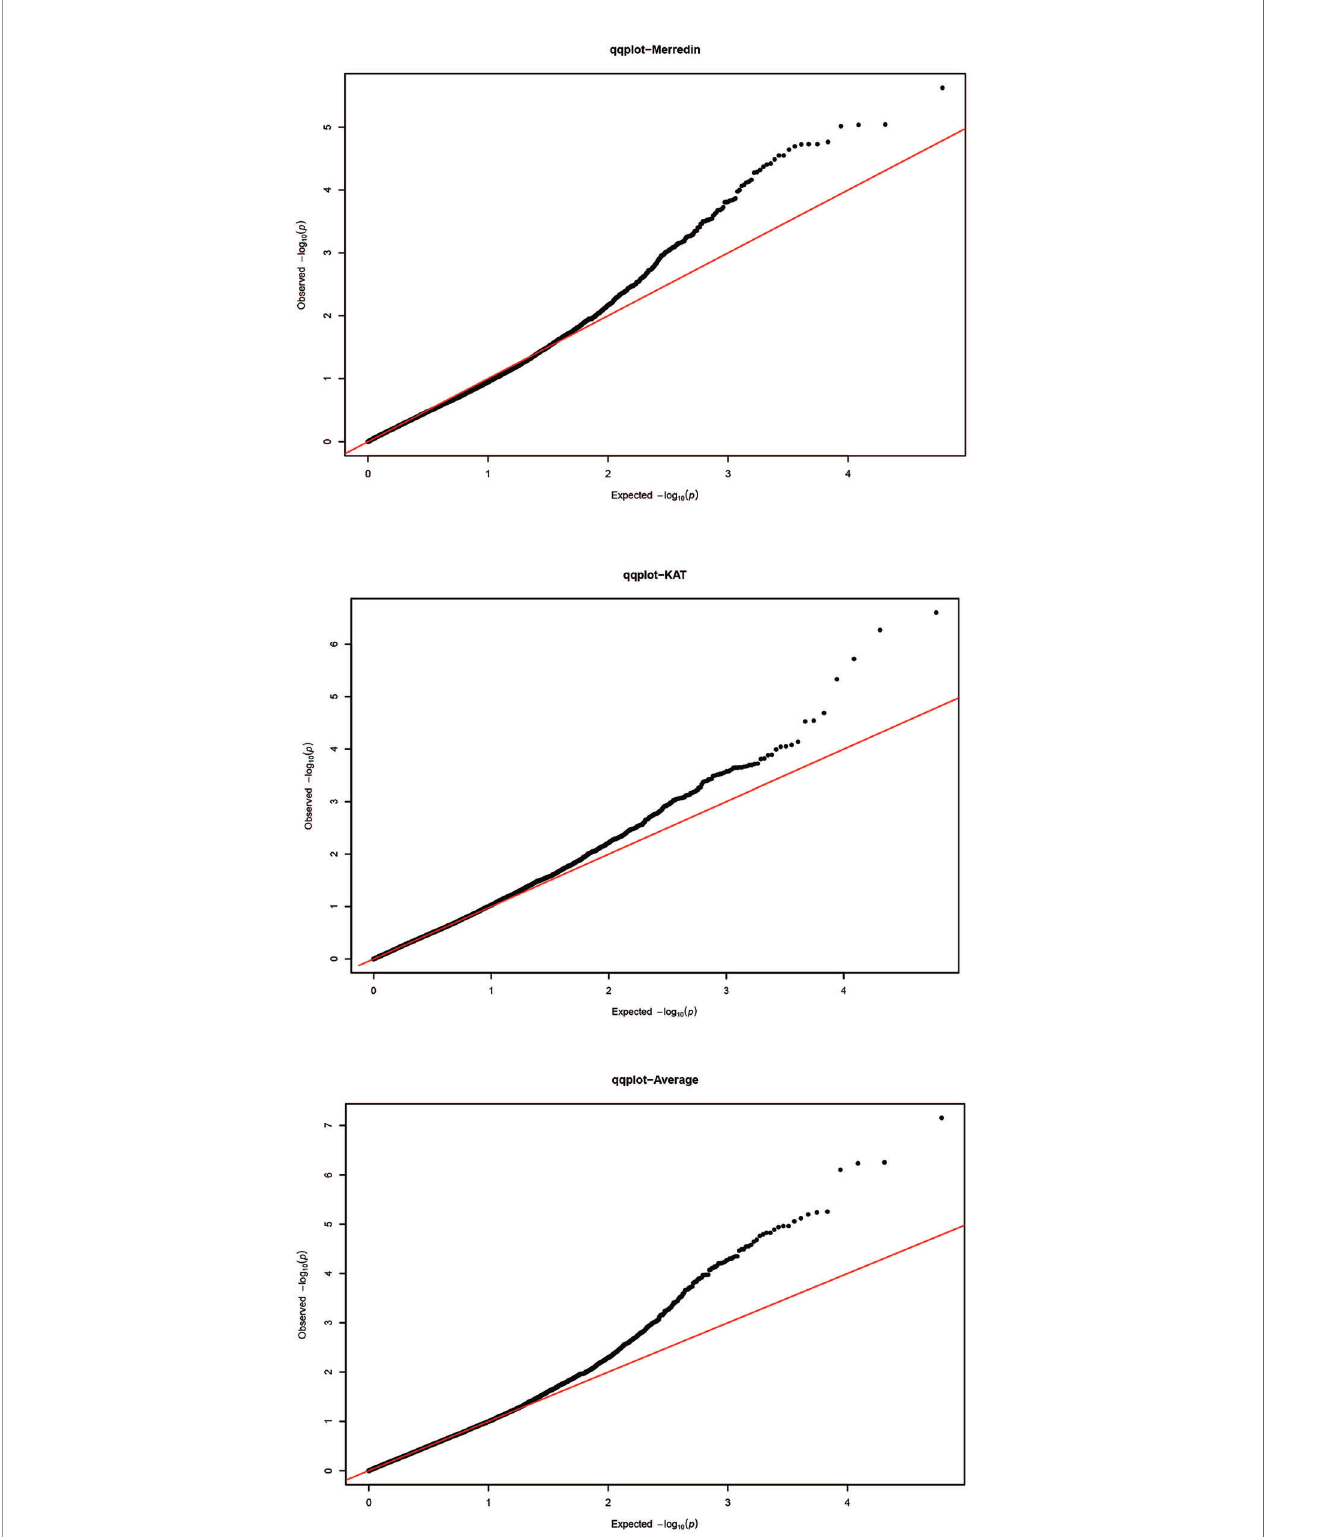
FIGURE 3 | Quantile – quantile (Q-Q) plots for genome-wide association study (GWAS) of 350 barley accessions grown in Merredin, Katanning, and average for salinity tolerance index during germination under 150 mM NaCl. The Y-axis is observed – log (P) values, and X-axis the